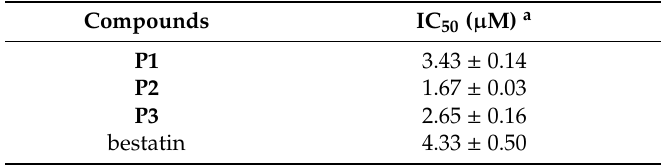
Table 2. APN inhibitory activities of compounds P1 , P2 , P3 and bestatin.